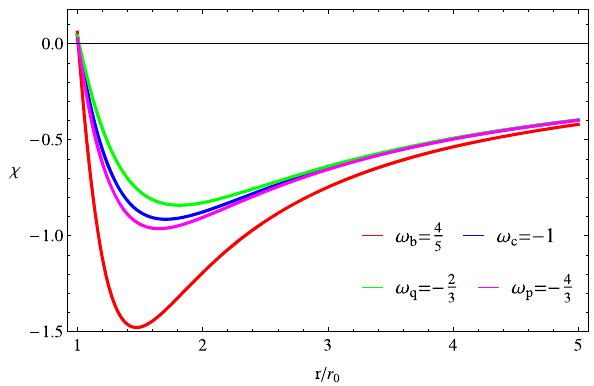
Fig. 9 The exoticity parameter χ against the dimensionless radial coordinate r / r 0 . These curves were obtained by considering the val- ues mentioned in Table 3, for the model #1